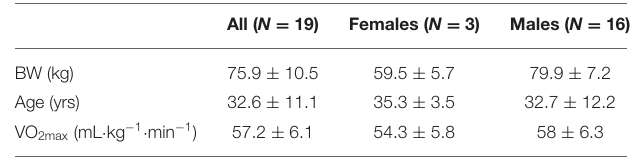
TABLE 1 | Characteristics of